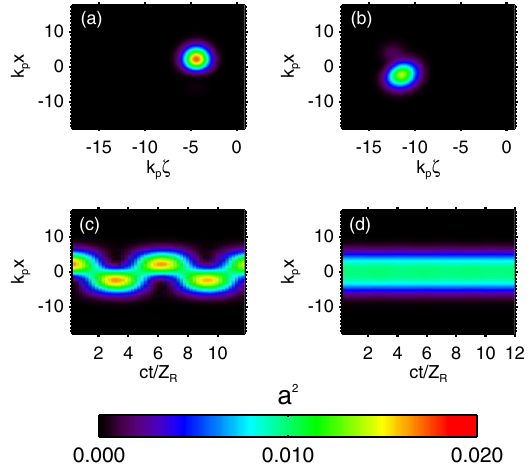
FIG. 2. Normalized intensity profile as a function of longitu- ð z (cid:3) ct Þ and transverse k (cid:4) ¼ k x coordinates, for a dinal k p p p fundamental Gaussian plus a first-order Hermite-Gaussian mode, with the same polarization, propagating in a matched plasma ¼ 0 : 22 and channel in 2D Cartesian geometry, at (a) ct=Z R ¼ 10 ; (c) corresponding transverse intensity profile, (b) ct=Z R integrated over the longitudinal dimension, as a function of propagation distance. (d) Integrated transverse intensity profile of the two modes with